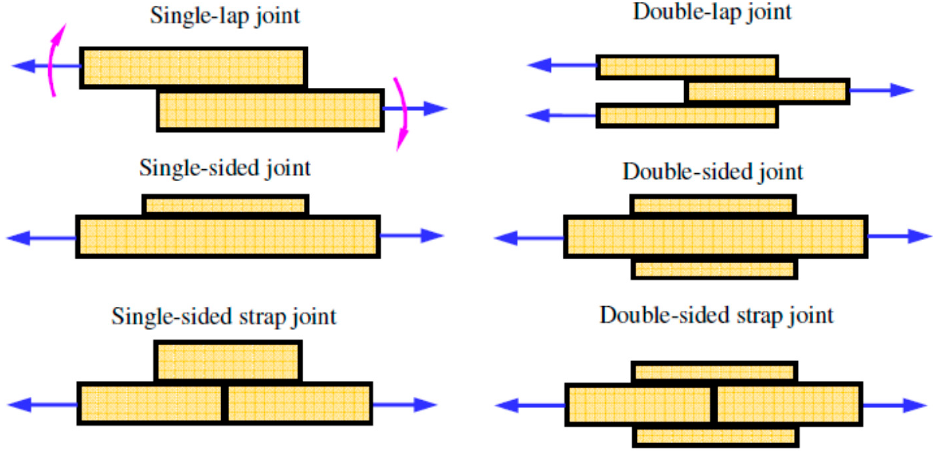
Figure 1. Typical adhesively bonded joints (ABJs) made of adherends bonded with adhesives.